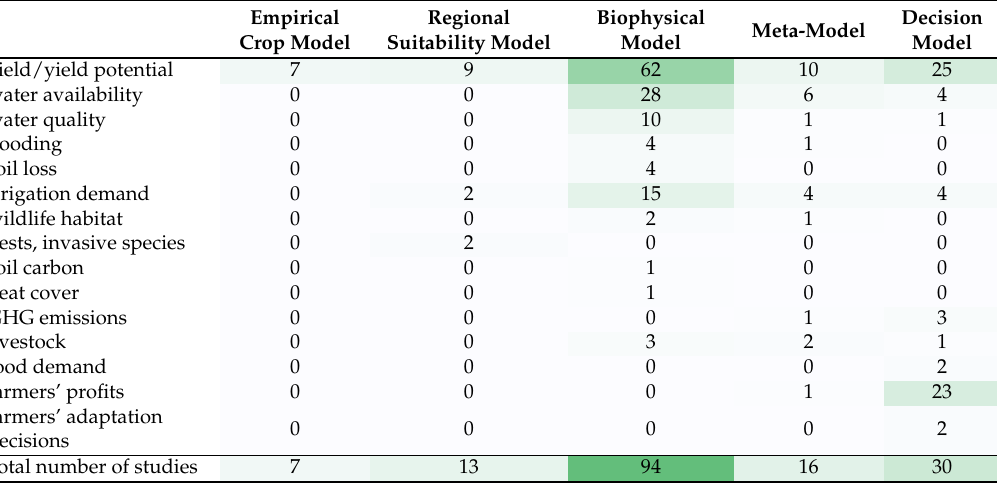
Table 1. Number of modelling studies simulating impacts on different objectives with each of the five identified model